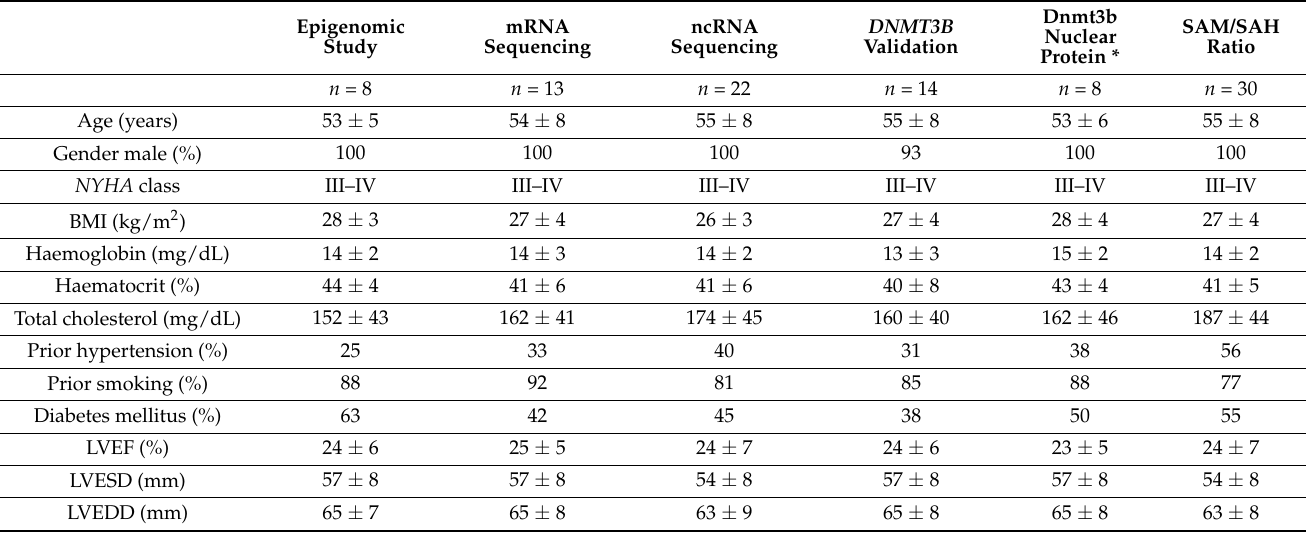
Table 1. Clinical characteristics of ischaemic cardiomyopathy